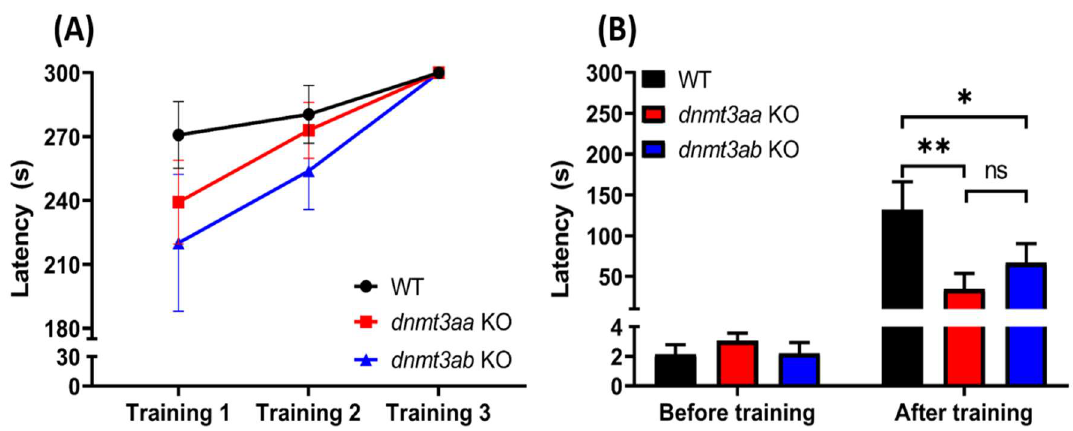
Figure 10. Comparison of short-term memory between wild type, dnmt3aa KO, and dnmt3ab KO mutant zebrafish. ( A ) The latency of fish swimming into the dark chamber after electrical shock was given in three training sessions. ( B ) The latency of fish swimming into the dark chamber one day after training sessions. Data were analyzed with two-way ANOVA followed by Tukey post hoc test. The data are presented with mean ± S.E.M. ( n = 15 for WT and dnmt3ab KO fish; n = 16 for dnmt3aa KO fish, * p < 0.05, ** p < 0.01) .